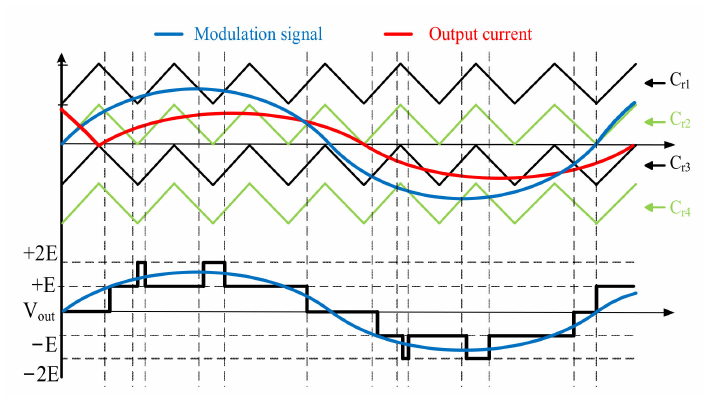
Figure 2. Traditional modulation strategy of the ANPC-5L inverter.